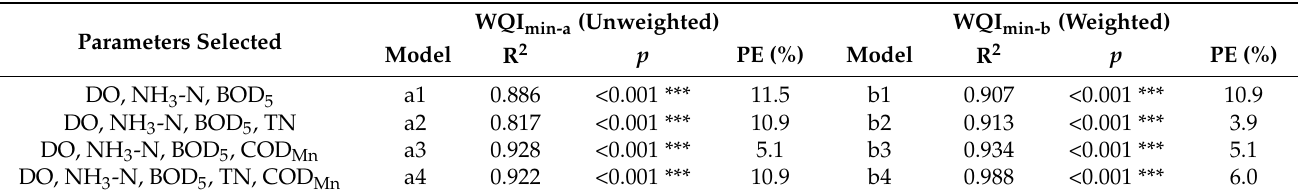
Table 5. The degree of explanation of WQI by the two WQImin models based on whether weights are considered (n = 36).